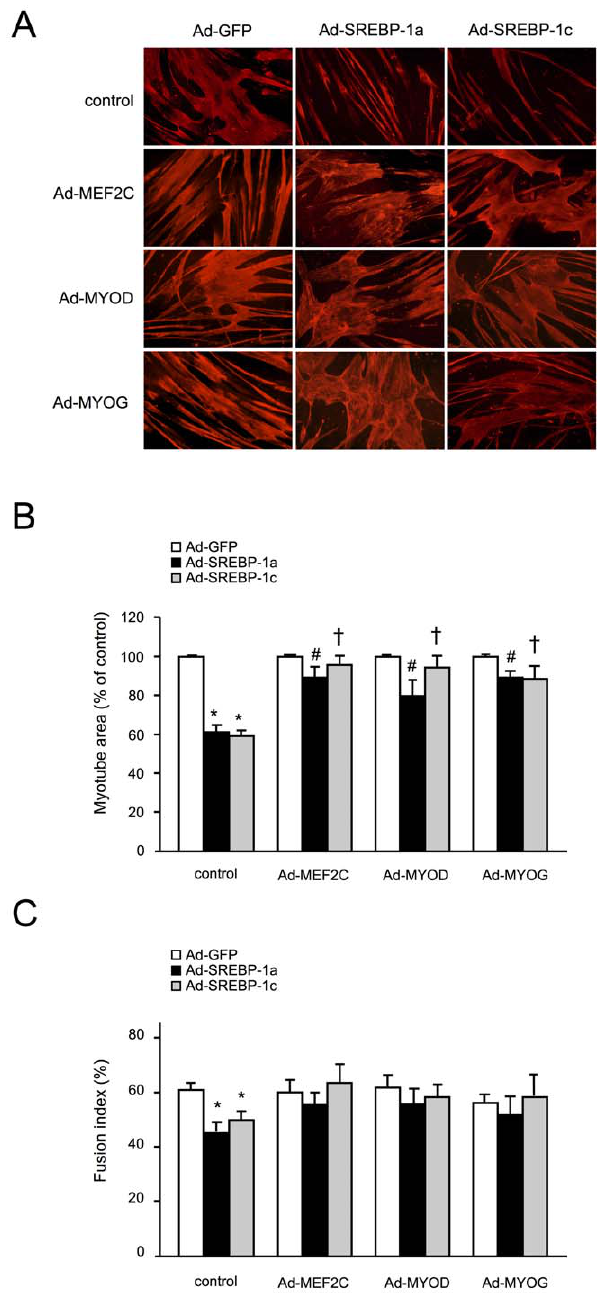
Figure 2. Expression of MEF2C, MYOD1 and MYOG inhibits SREBP-1 induced atrophy in myotubes. Human myotubes were infected for 48 h with recombinant adenoviruses encoding GFP, SREBP- 1a or SREBP-1c, in combination with viruses expressing MEF2C, MYOD1, MYOG or GFP (control). (A) Representative images of myotube immunostaining with Myosin Heavy Chain antibody. (B) Myotube areas were measured as cell surface determination from MHC immunostain- ing pictures. The results are the means 6 SE of 5 independent experiments (with 10 fields considered for each condition). *p , 0.001 compared to Ad-GFP infected cells. # p , 0.05 compared with Ad-SREBP- 1a alone ; { p , 0.05 compared with Ad-SREBP-1c alone; (C) Fusion index. The number of nuclei (total and in myotubes) was counted in all 12 conditions (with at least 4 fields for each condition). The results are the means 6 SE of 3 independent experiments. *p , 0.05 compared to Ad- GFP infected cells.